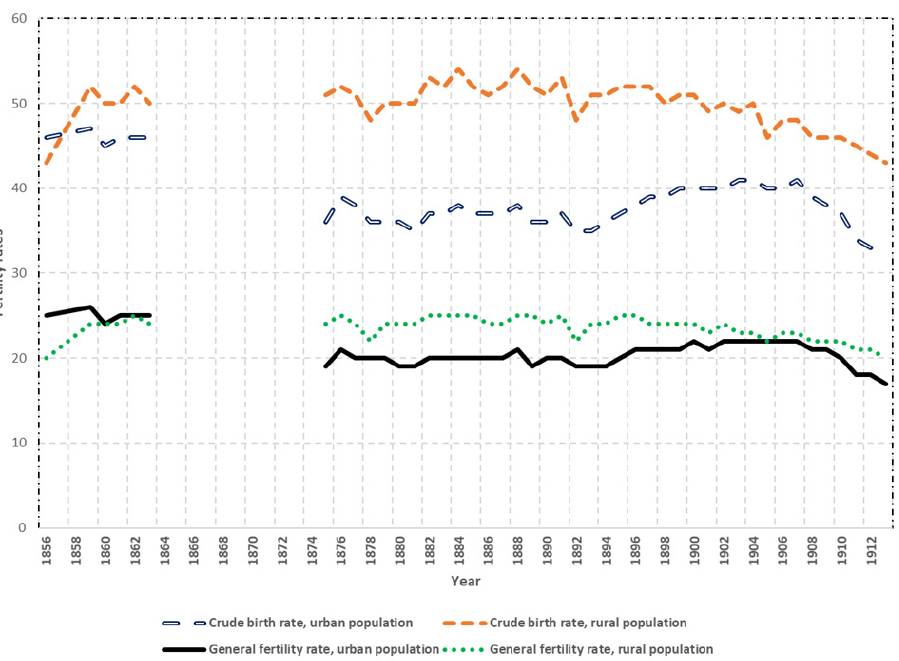
Fig. 1. Crude birth and general fertility rates among urban and rural population in European Russia in 1856-1913, %. Sources : (Military Statistical collection 1871: 53-67; Population movement... 1861-1916; Novoselsky 1916: 36-37; Report on … 1898-1916).